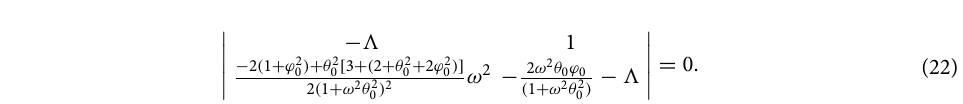
Figure 5. Reveals the variation of ω with σ according to different values of time delay: ( a ) τ = 0.001 , ( b ) τ = 0.01 , and ( c ) τ = 0.1 .